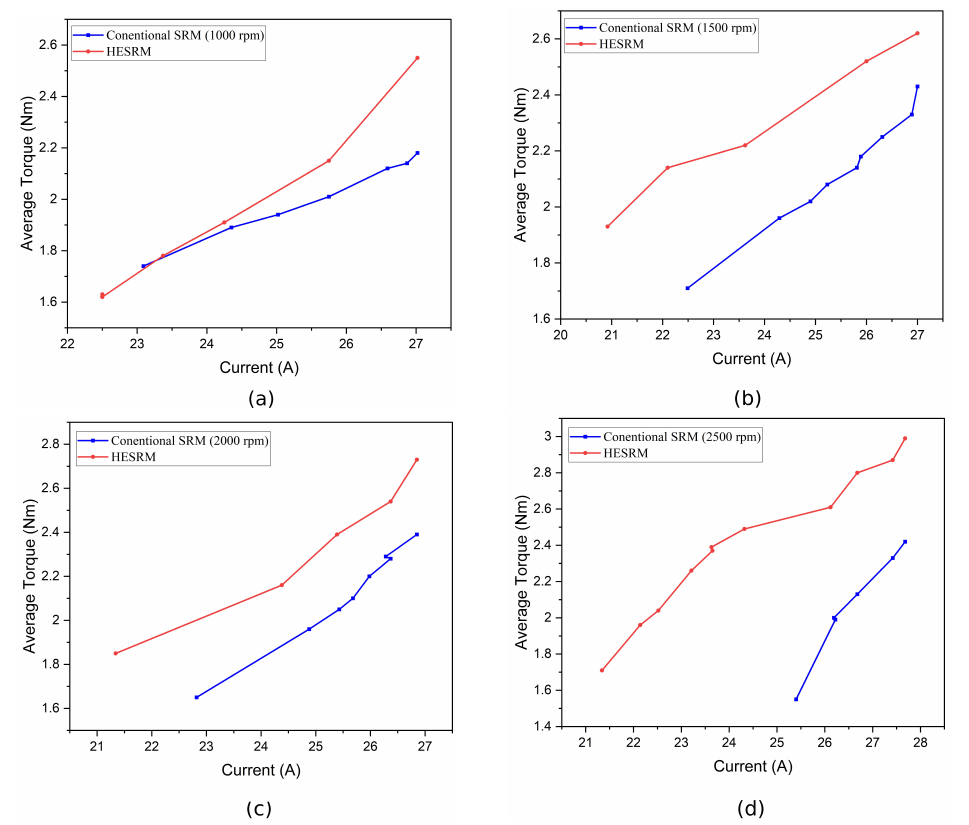
Figure 17. Comparison of average torque with variable speed for conventional SRM and proposed HESRM: ( a ) 1000, ( b ) 1500, ( c ) 2000, and ( d ) 2500